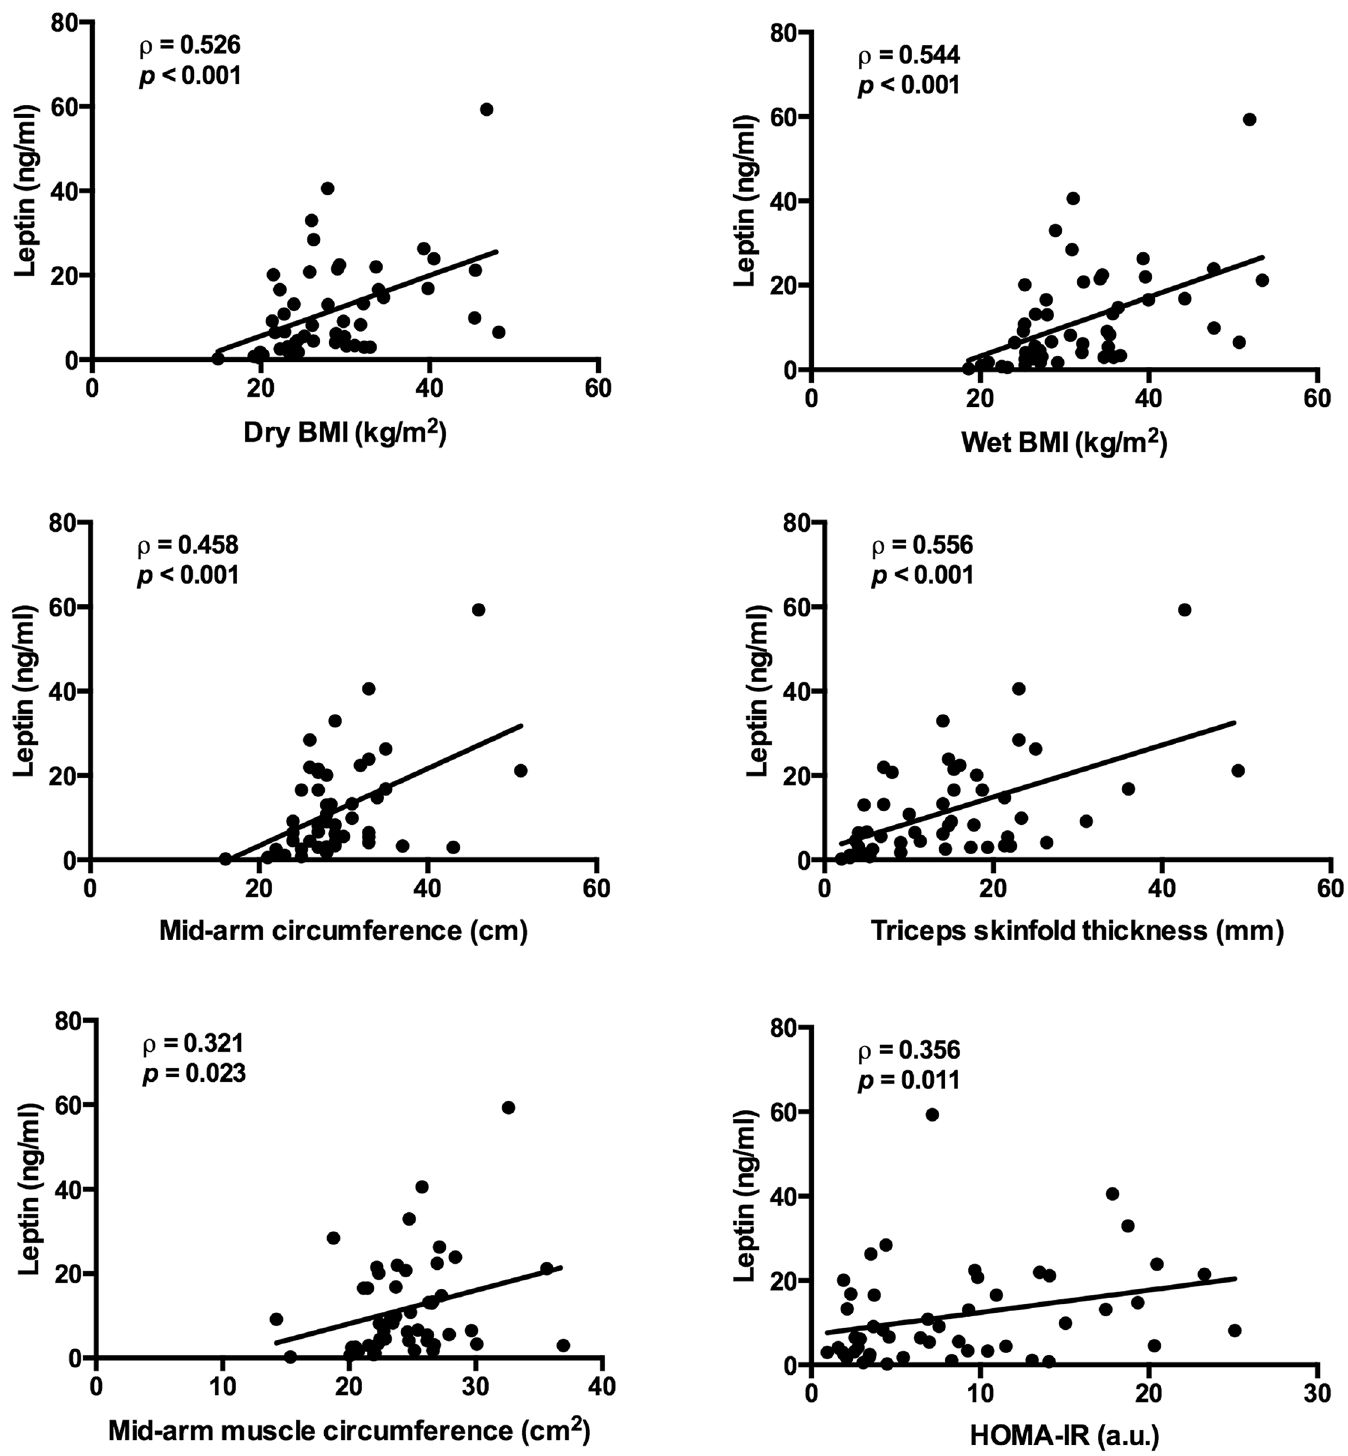
Fig 3. Spearman correlations of serum leptin with dry BMI, wet BMI, mid-arm circumference, triceps skinfold thickness, mid-arm muscle circumference, and HOMA-IR.